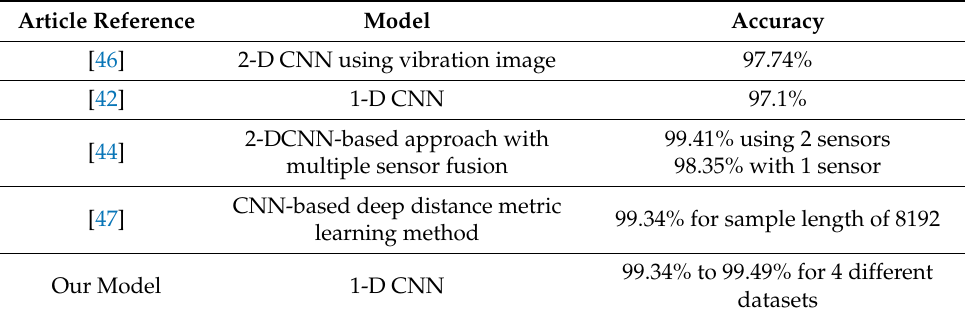
Table 6. Comparison of the proposed model with some published works.